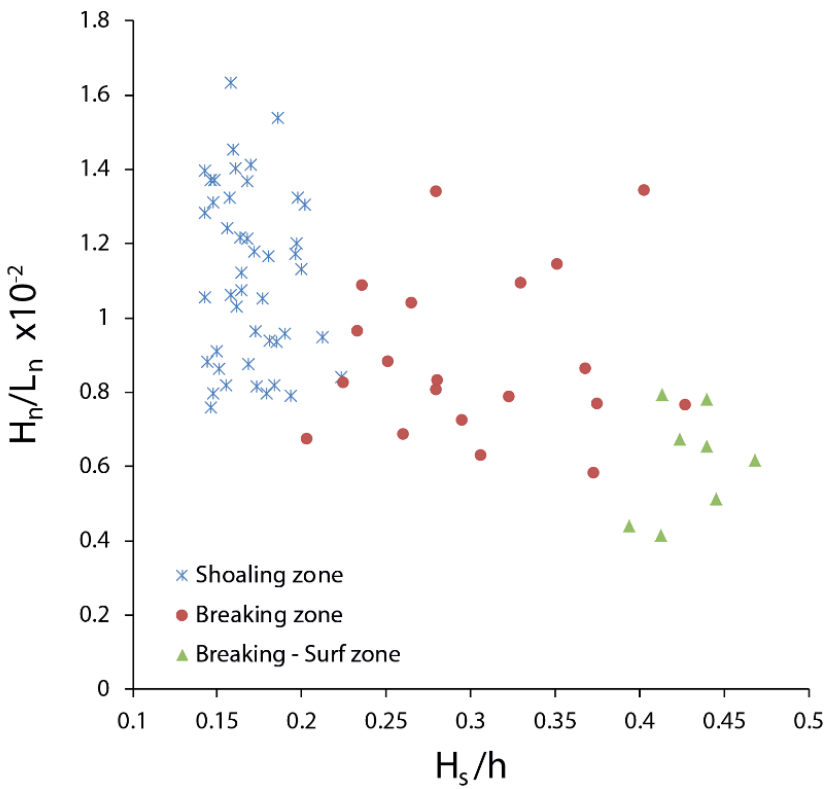
Figure 5. Relationship between nearshore wave steepness ( H n /L n ) measured in 5 m water depth and wave height to depth ratio ( H s /h ) measured on bar B3 on the lower beach (see Figure 2D for location). Wave length ( L n ) was calculated according to linear wave theory. The distinction between shoaling, breaking and surf zones is based on visual determination from video images.